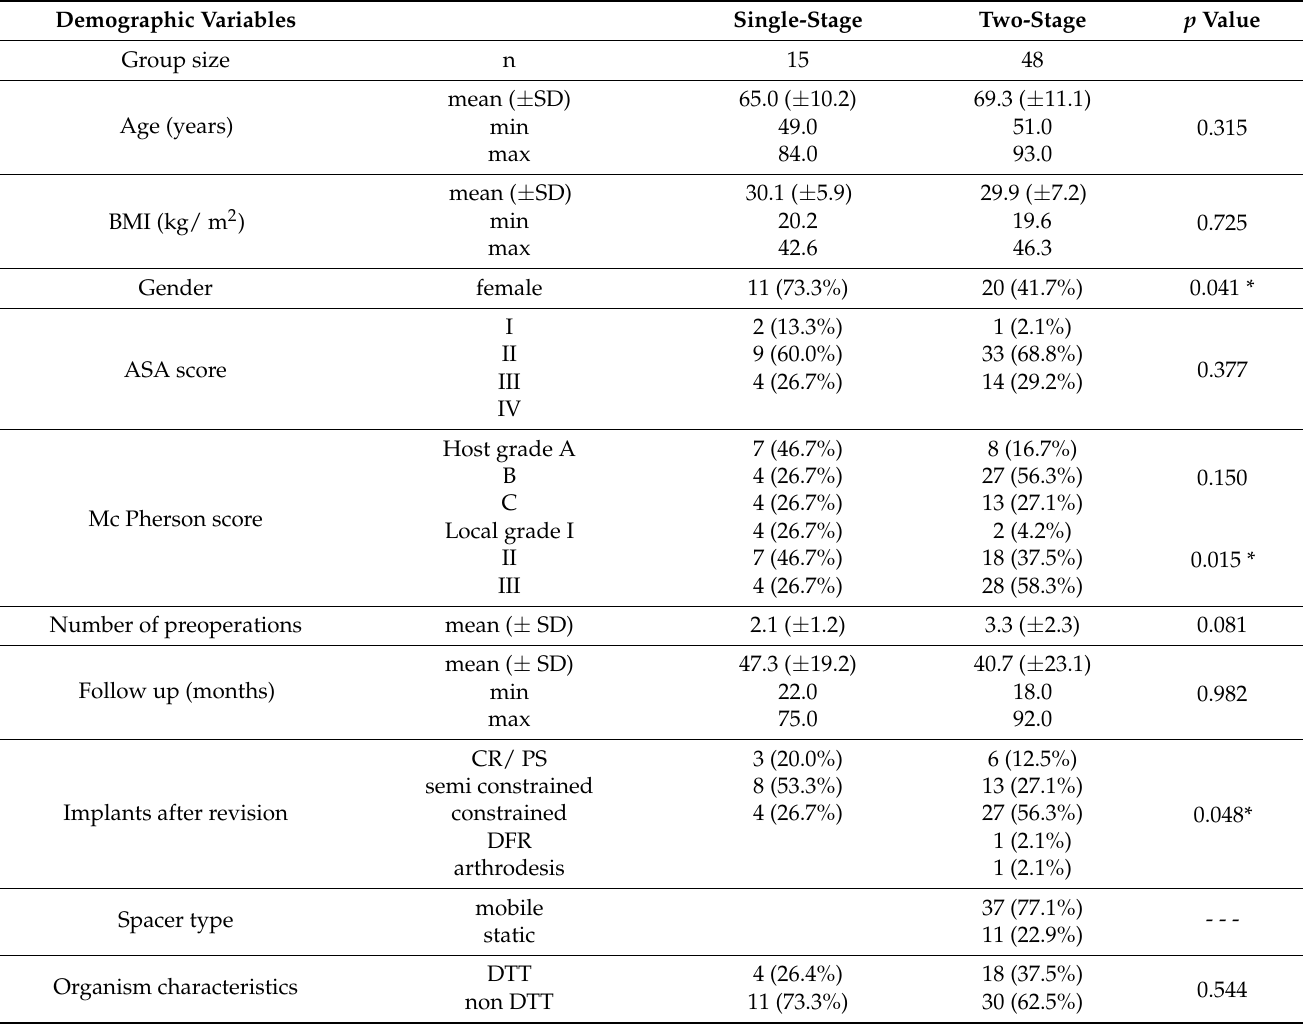
Table 1. Group-specific demographic